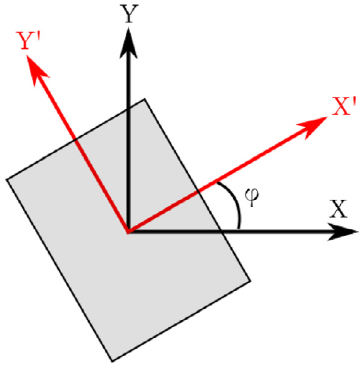
Figure 1. Rotated unit cell with respect to the original (unprimed) and the new (primed) coordinate system. The rotation angle is u